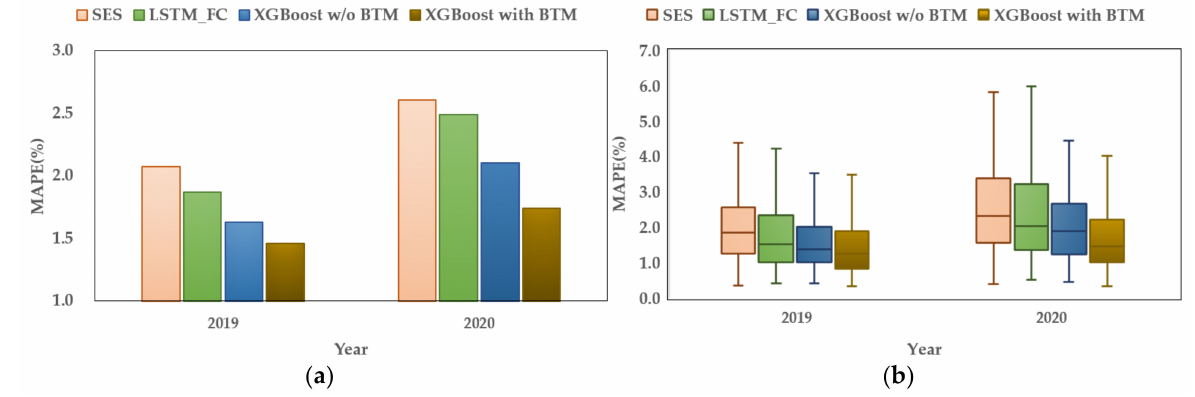
Figure 12. The MAPE of the forecasting methods by year: ( a ) bar plot of the average MAPE; ( b ) box plot of the MAPE.